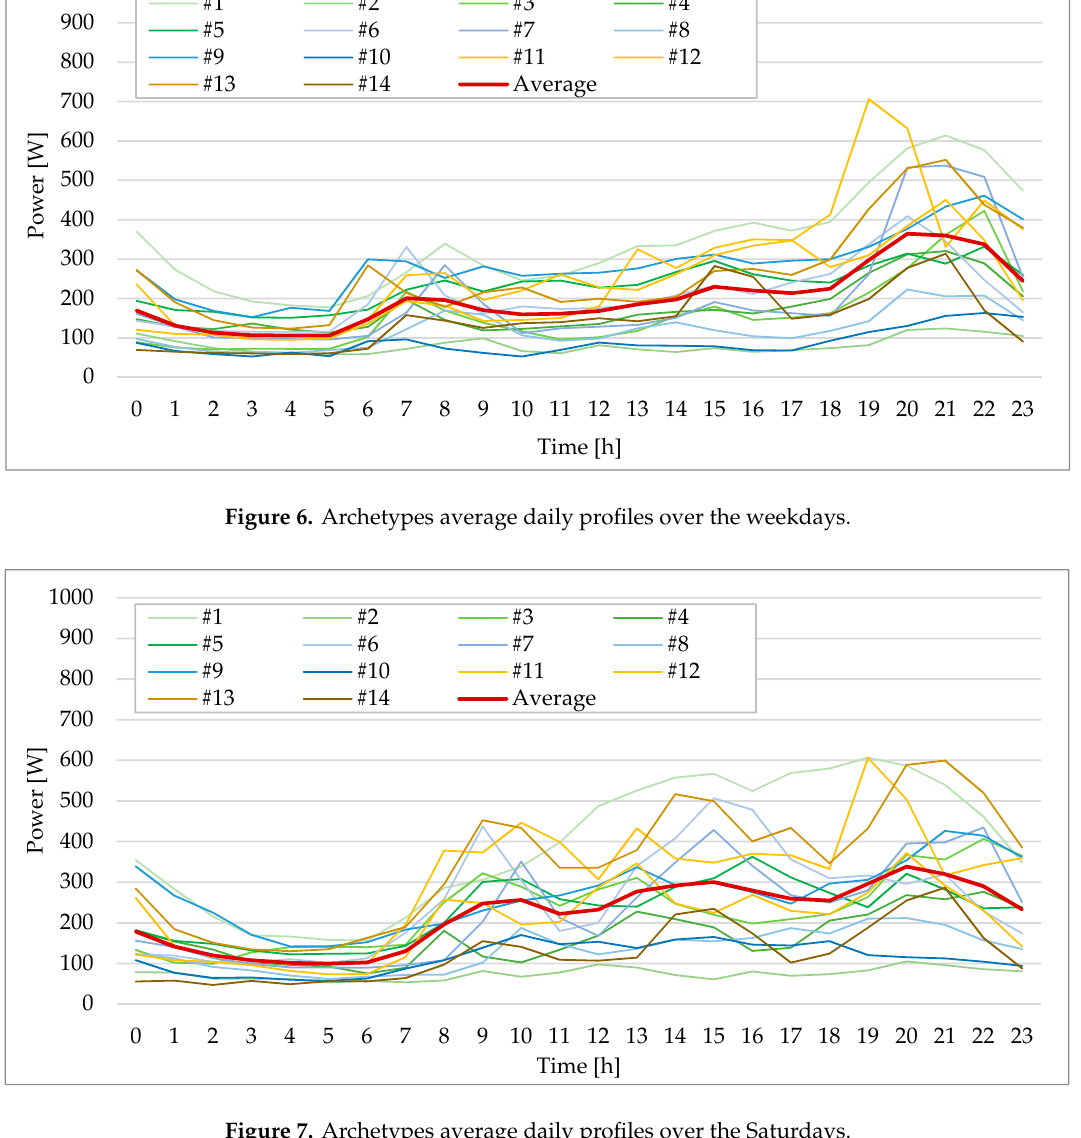
Figure 7. Archetypes average daily profiles over the Saturdays.